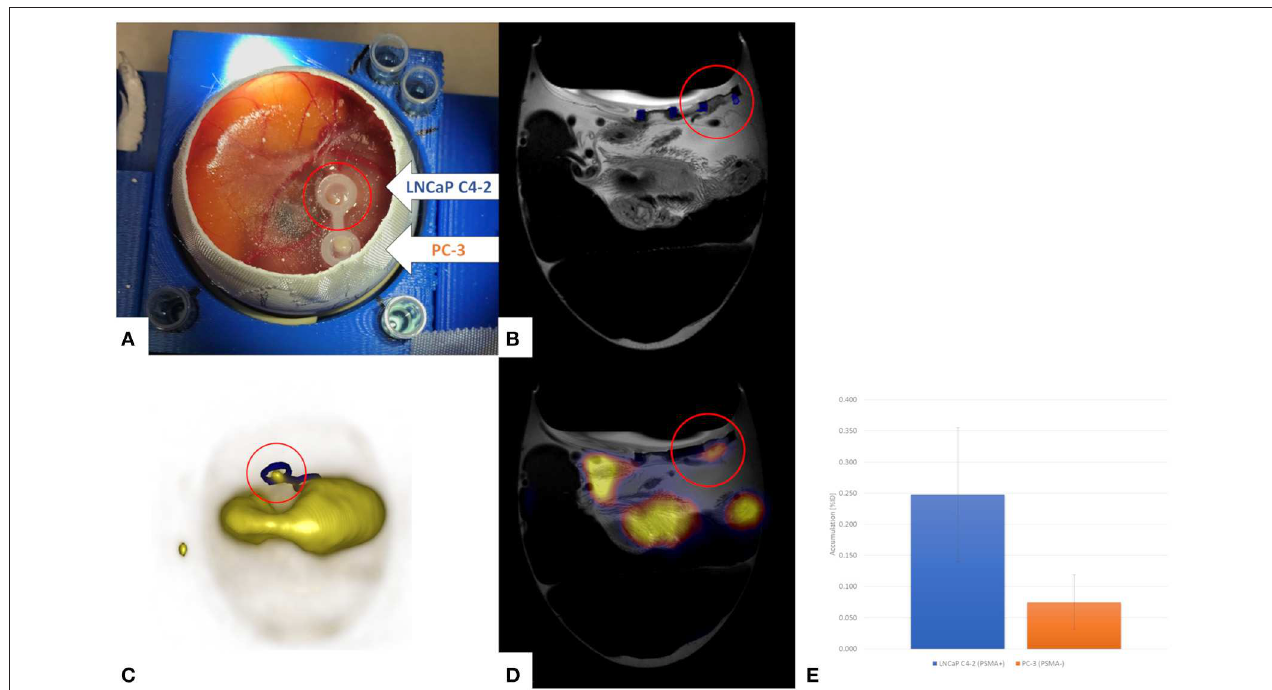
FIGURE 11 | PET/MRI for quantification of the PSMA-specific PET radiotracer [ 68 Ga]-PSMA-11 in the HET-CAM model with dual tumor seeding (LNCaP C4-2, PSMAQ17 positive; PC-3, PSMA negative) (A) . The tumors can be nicely visualized by high-resolution MRI ( B , red circle). Distribution of the [ 68 Ga]-PSMA-11 by PET reveals strong signal at one location of the CAM and some general accumulation in the chick embryo (C) . Fusion of the PET and MRI data (D) reveals tracer accumulation in the PSMA positive tumor (red circle), which is proven by gamma counting after resection of the tumors (E) . Unpublished imaging material provided by Winter G. and Li